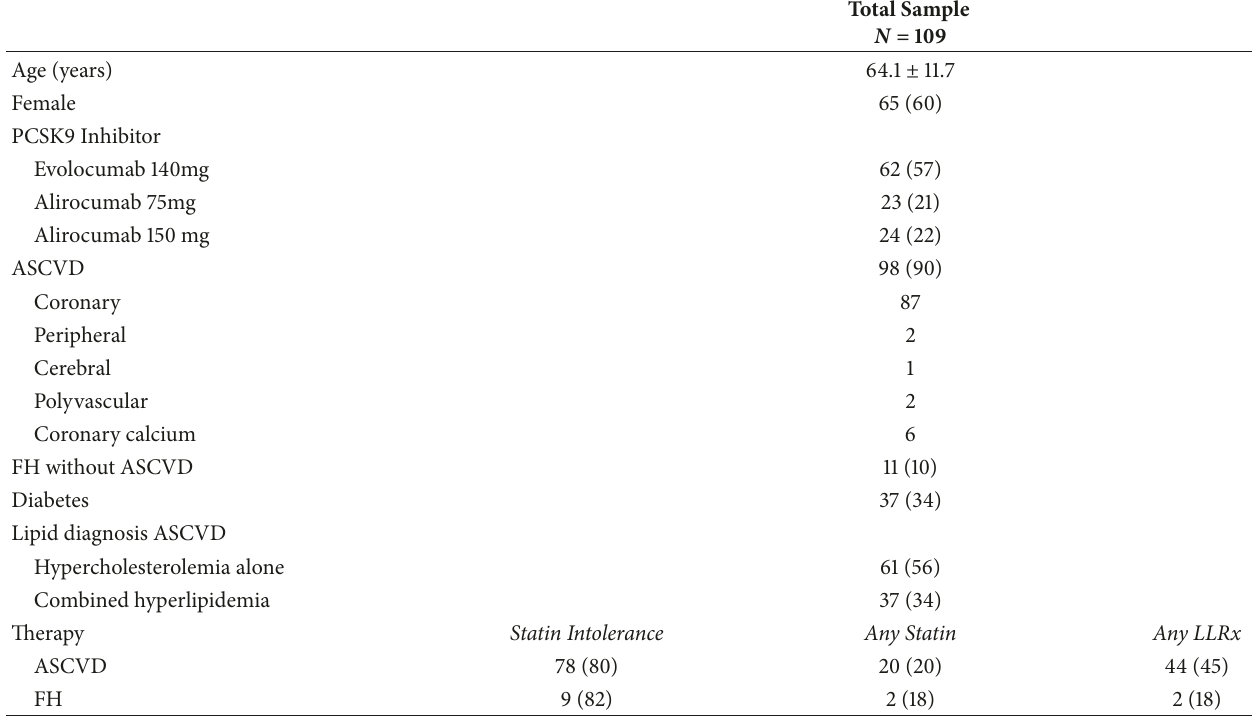
Table 1: Baseline characteristics of patient